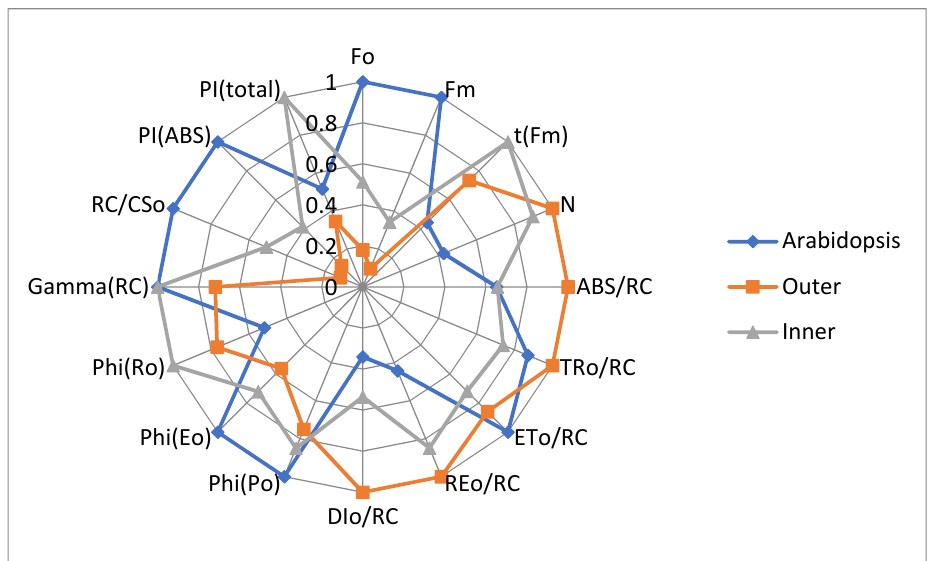
Figure 5. Radar chart of sixteen JIP-parameters calculated from the induction curves of the prompt Chl a fluorescence in outer and inner cortices of Smicronix galls and in leaves of the reference normal photosynthetic plant A. thaliana . The values of each parameter were normalized to the respective maximum.